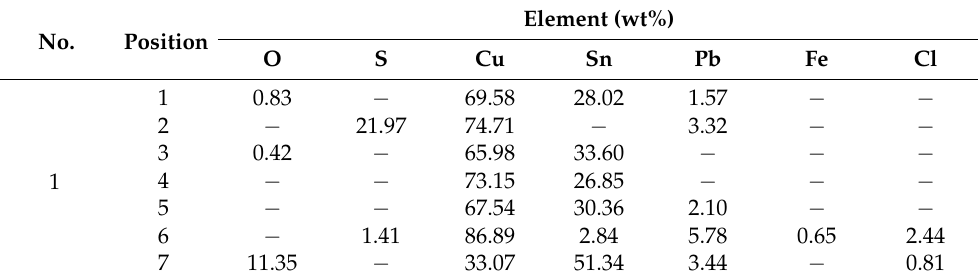
Table 1. Ga-2 (No. 1) microstructure energy dispersive spectrometer (EDS)